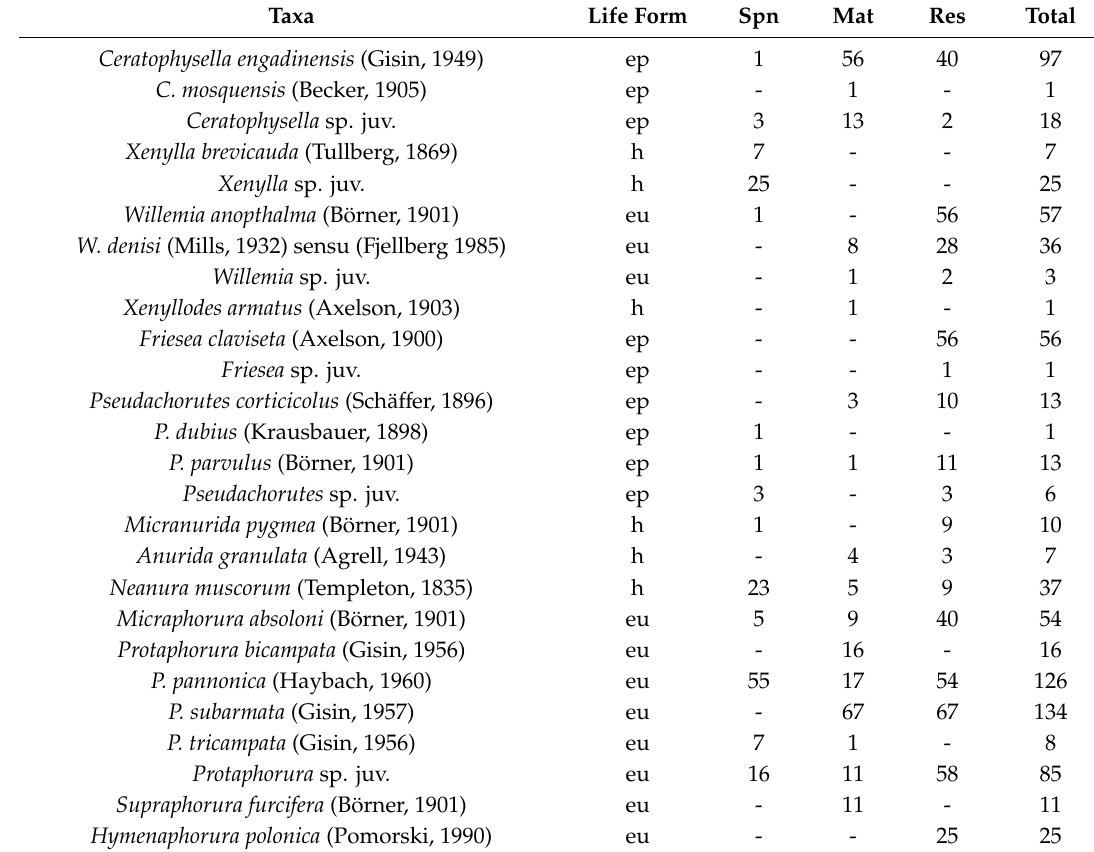
Figure S1. Stand in strict reserve of Białowie˙za National Park (photo T. Mokrzycki); Figure S2. The mature forest in the managed part of Białowie˙za Forest (photo M. Sławski); Figure S3. The stands spontaneously developed on large-scale clear-cuts (photo T.